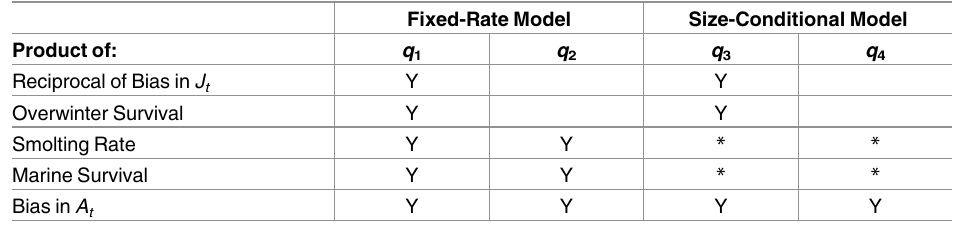
Table 2. Interpretation of the apparent transition rates q x